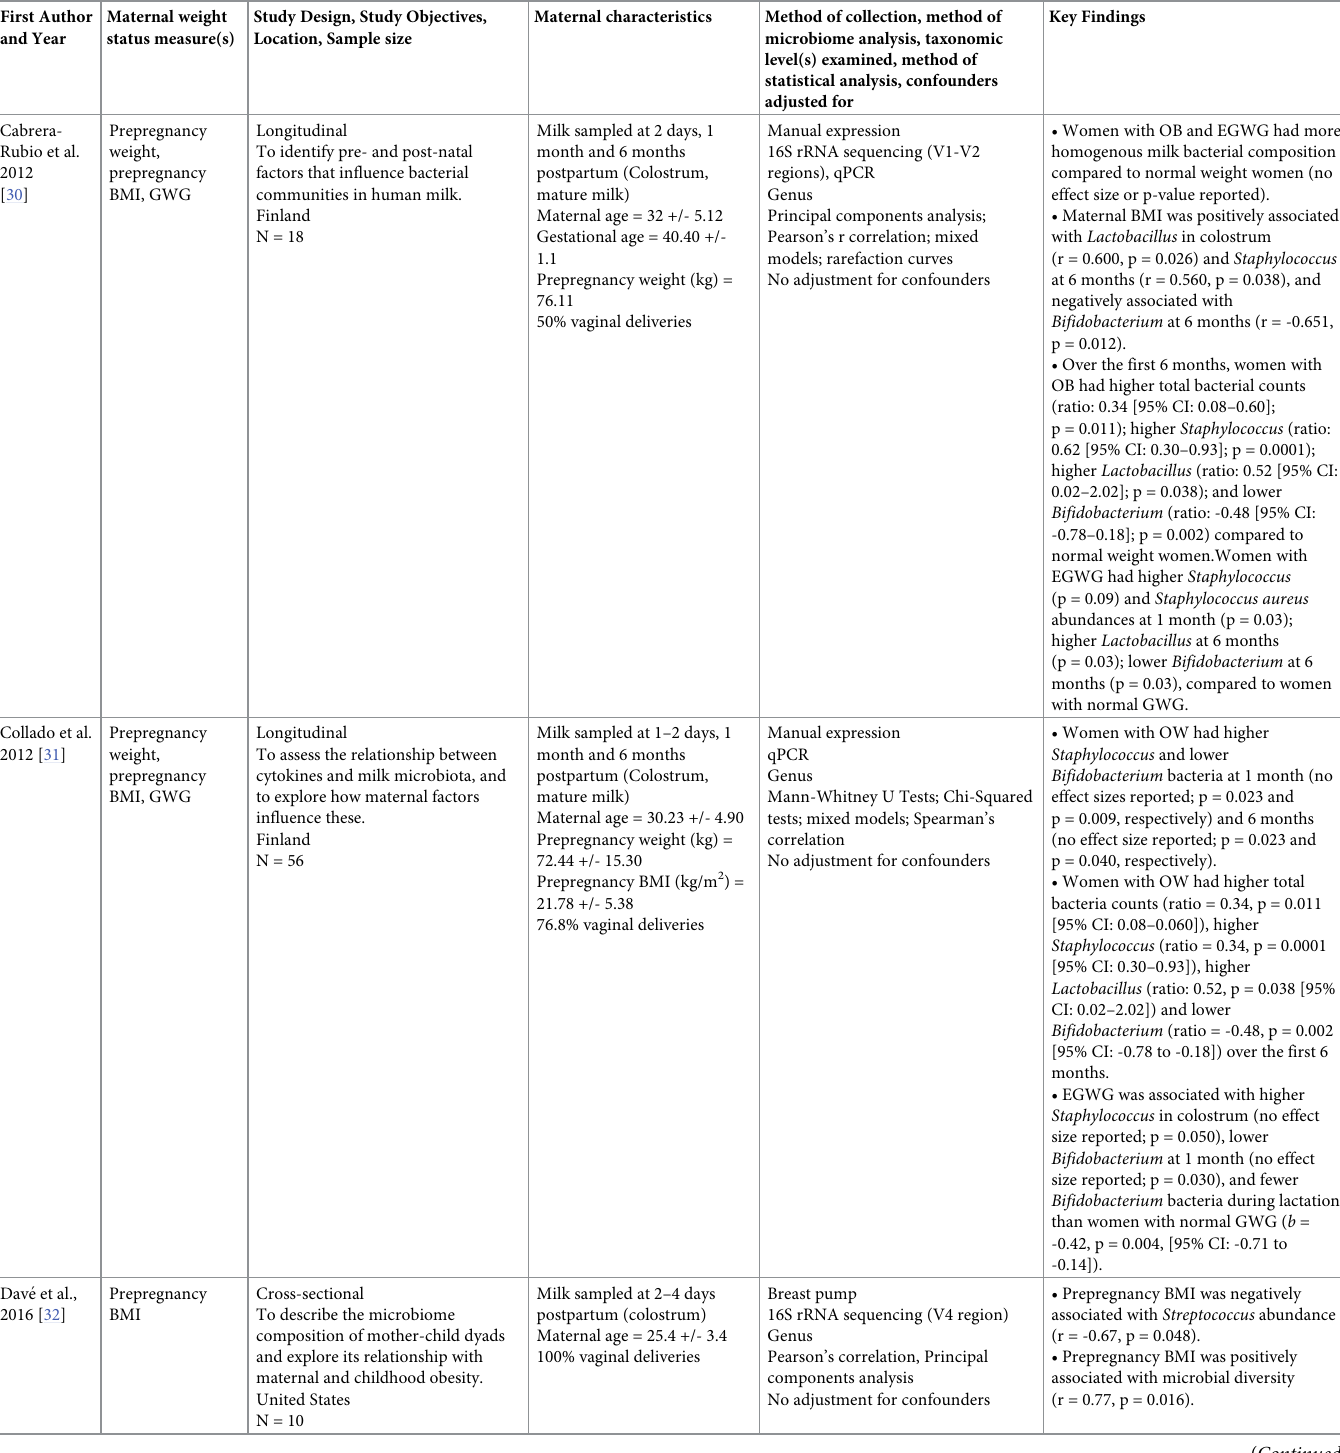
Table 1. Key findings of included